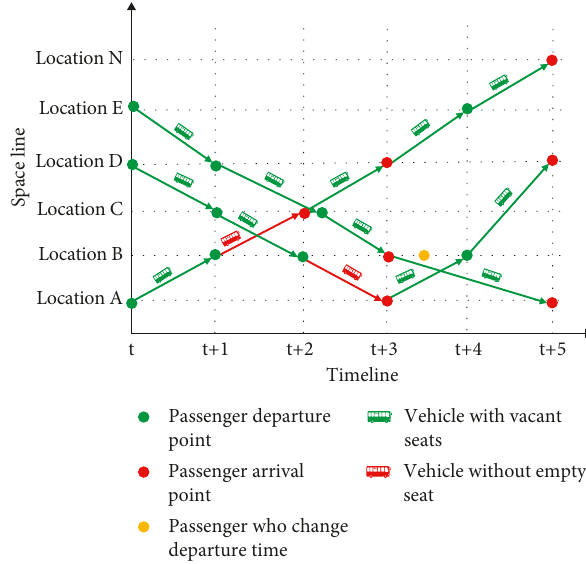
Figure 2: Space-time network of the slack departure